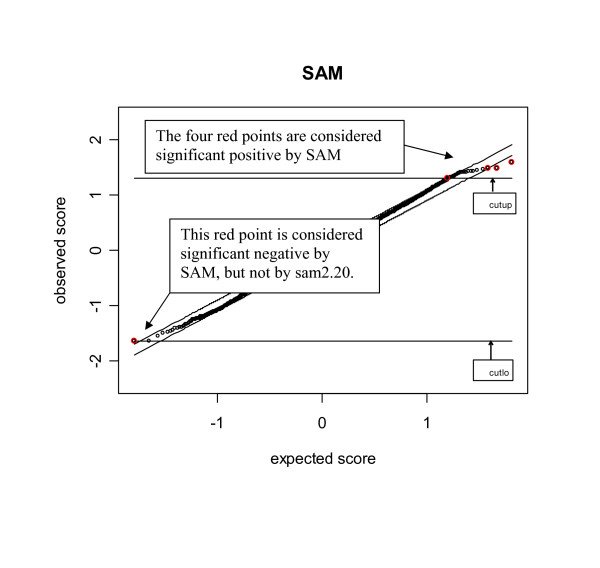
The SAM plot obtained by using the SAM algorithm. The red points are the points declared significant by SAM. The two horizontal lines refer to the lower cutoff δL (=cutlo) and the upper cutoff δU (=cutlup) from SAM. The threshold used is Δ = 0.099.